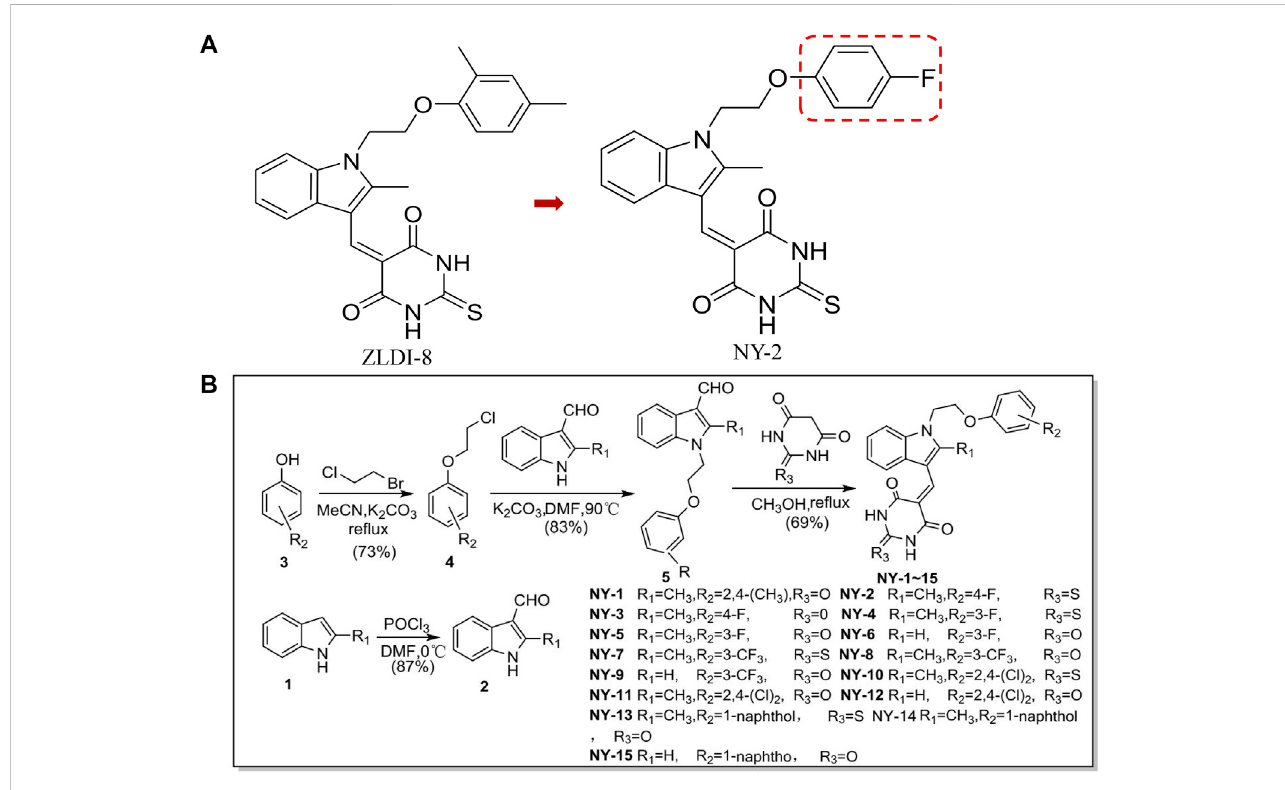
FIGURE 1 Chemical structures of ZLDI-8 and NY-2 (A) . Chemical structures of the derivatives, NY-1 to -15 (B) .